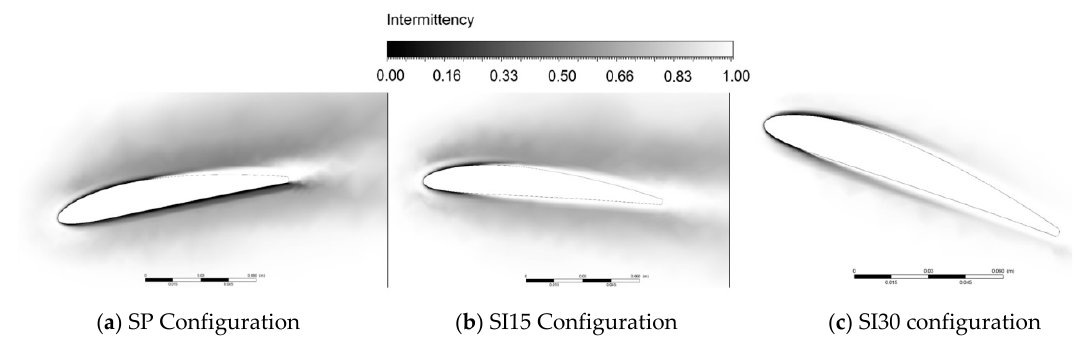
Figure 15. The intermittency contours around the first blade at the mid-span plane: SP ( a ), SI15 ( b ), and SI30 ( c ) configurations. The black color indicates the laminar flow. Flow progresses from bottom to top.